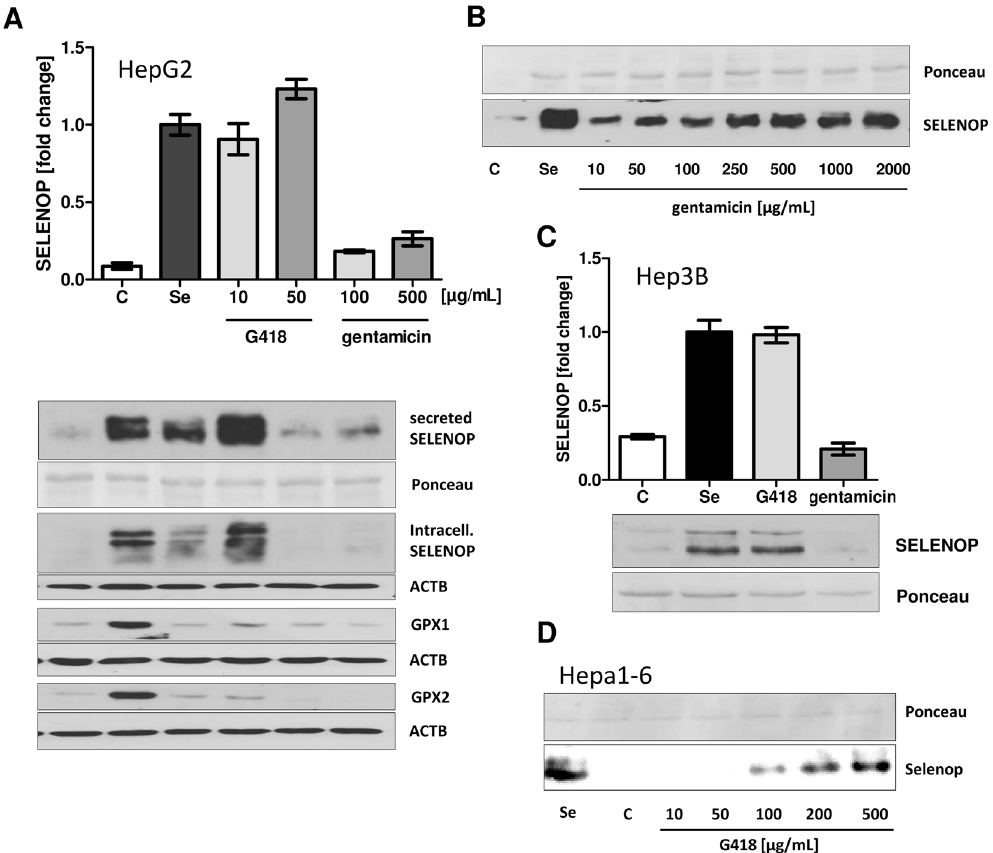
Figure 1. In vitro effects of G418 and gentamicin on selenoprotein biosynthesis. ( A ) HepG2 cells were incubated for 48 h in FCS-free medium with supplemental selenite (100 nM), G418 or gentamicin. Western blot analysis indicates increased secreted SELENOP protein levels in response to selenite and G418 treatment. Intracellular protein levels of selenoenzymes GPX1 and GPX2 were marginally affected. ( B ) The effect of gentamicin was verified in a dose-dependent analysis. ( C ) The effects of G418 on SELENOP secretion were replicated in human Hep3B, and ( D ) murine Hepa1-6 hepatocytes.